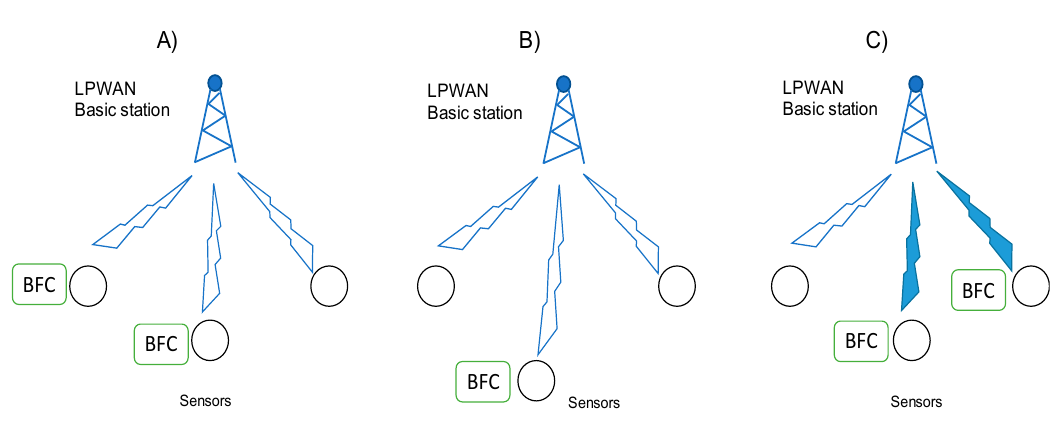
Figure 2. Variants of microbial fuel cell (MFC) applications for low-power wide-area networks (LPWANs). ( A ) MFCs used as a power supply for wireless sensors to increase the time of operation; ( B ) MFCs as an additional power source for sensor transmitters to increase the distance of transmission; ( C ) MFCs as an additional power source to increase the amount of data from sensors.